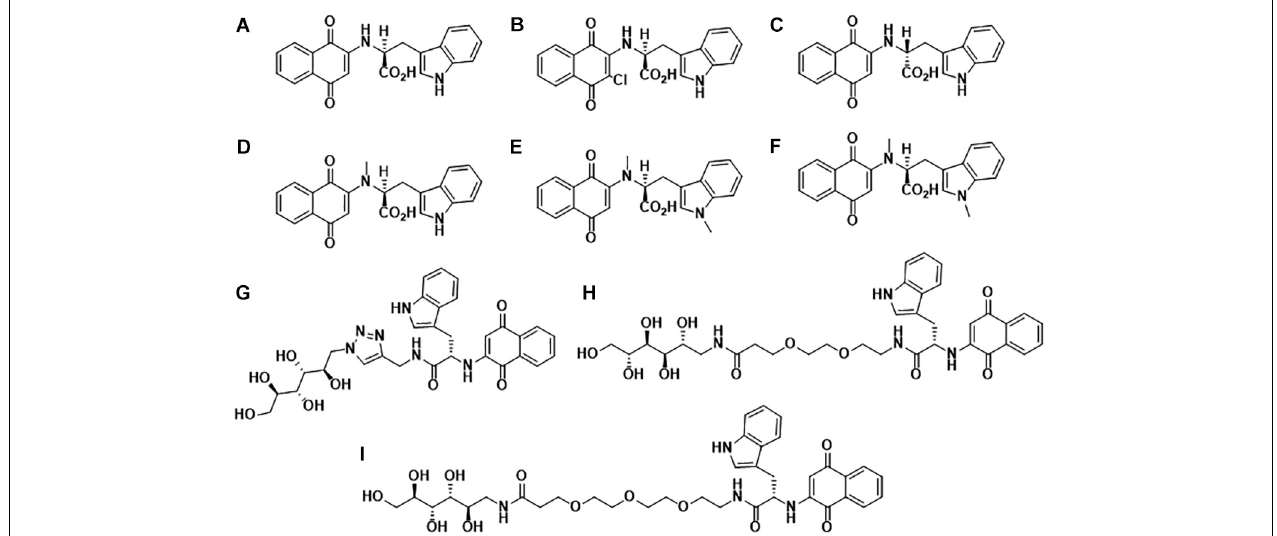
FIGURE 1 | Molecular structures of Naphthoquinone Tryptophan hybrids: (A) 1,4-naphthoquinone-2-yl- L -tryptophan (NQTrp), (B) Chloro-Naphthoquinone Tryptophan (Cl-NQTrp), (C) 1,4-naphthoquinone-2-yl- D -tryptophan (NQ-D-Trp), (D) N -methylamino-NQTrp (AM), (E) N -methylindole-NQTrp (IM),